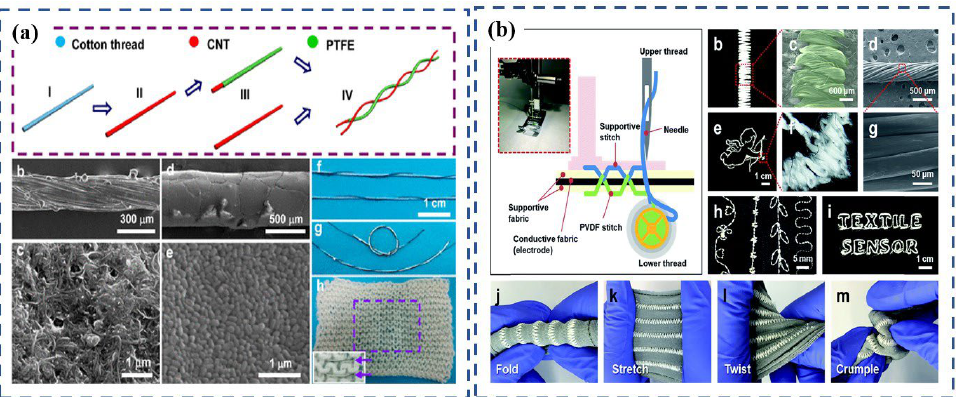
Figure 7. ( a ) Schematic diagram illustrating the fabricating process of an FBG that is made from CNT-coated cotton thread and PTFE thread. Reproduced with permission [84]. Copyright 2014, American Chemical Society. ( b ) PVDF stitch-based triboelectric textile sensors. Reproduced with permission [81]. Copyright 2018, The Royal Society of Chemistry.